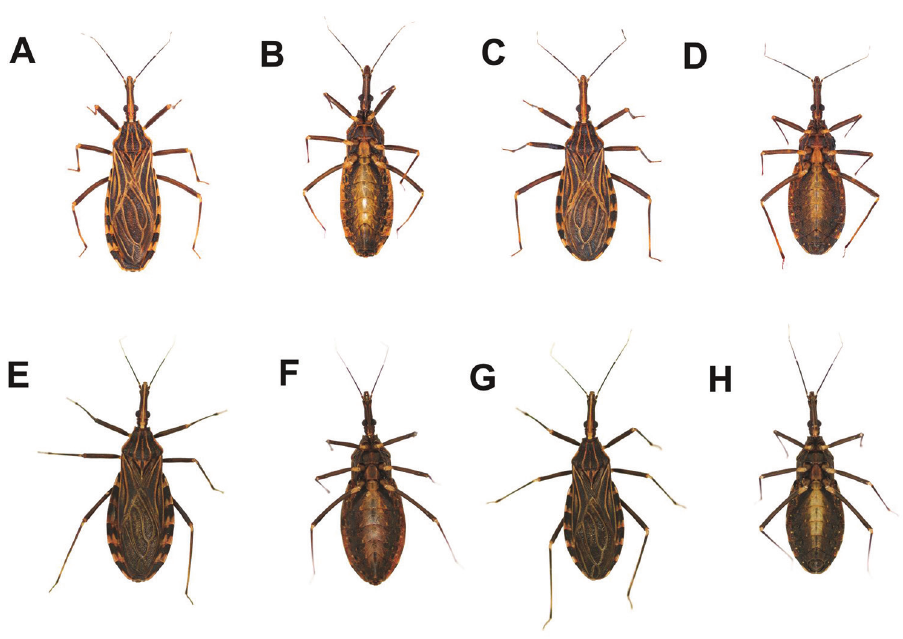
Figure 2. R. taquarussuensis sp. n. female A dorsal side B ventral side, R. taquarussuensis sp. n. male C dorsal side D ventral side, R. neglectus female E dorsal side F ventral side), R. neglectus male G dorsal side H ventral